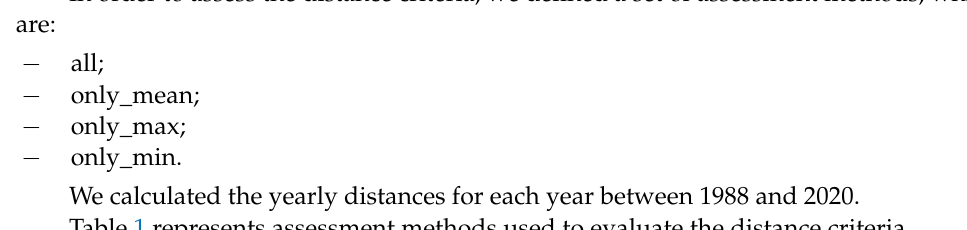
Table 1. Assessment methods for the evaluation of distance criteria. Distance to Oil Palm Distance to River Distance to Road distance_op_mean distance_rivers_mean